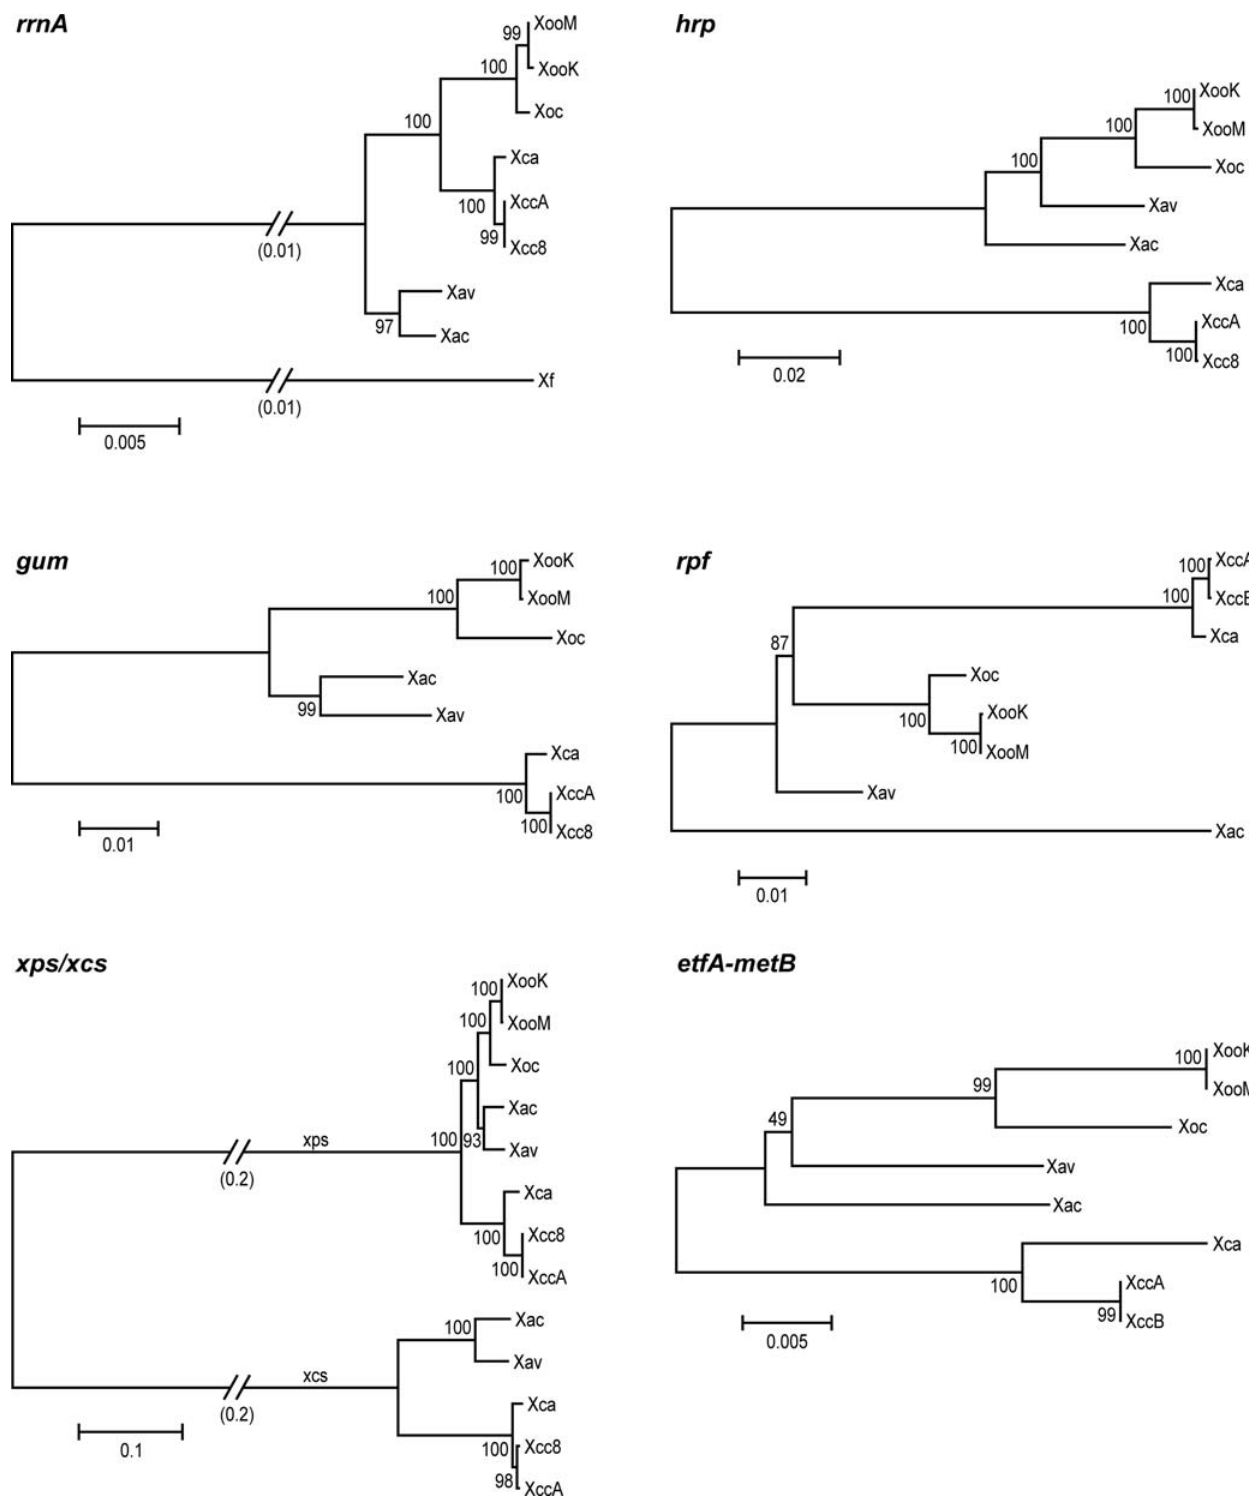
Figure 2. Relationships across Xanthomonas strains of ribosomal RNA sequences and sequences of pathogenesis-associated gene clusters. Phylogenetic trees generated as described in Materials and Methods are shown. rrnA , the rrnA operon (nucleotide alignment); gum , GumB through GumJ; xps/xcs , XpsD plus XpsE through XpsN, and XcsD through XpsM plus XpsC; hrp , HpaB through Hpa2; rpf , AcnB through RpfD; etfA- metB , EtfA and MetB, which flank the LPS biosynthetic locus (see Figure 1E). Strain abbreviations are as in the text. Sequence from Xylella